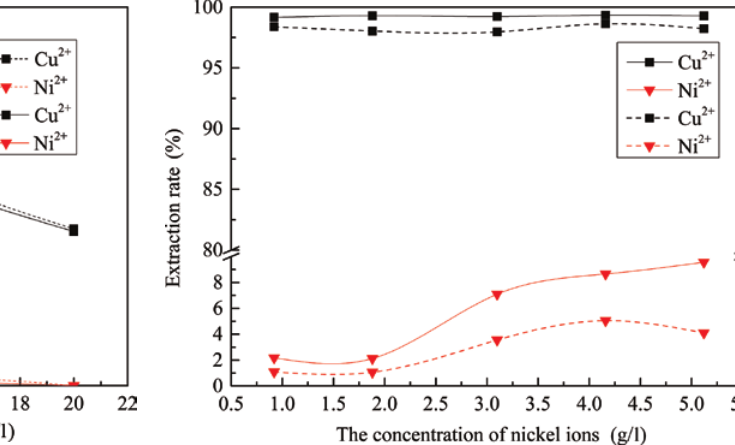
Figure 10: Effect of nickel ions concentration on extraction efficiency. ( ) Microfluidic extraction; ( ) conventional